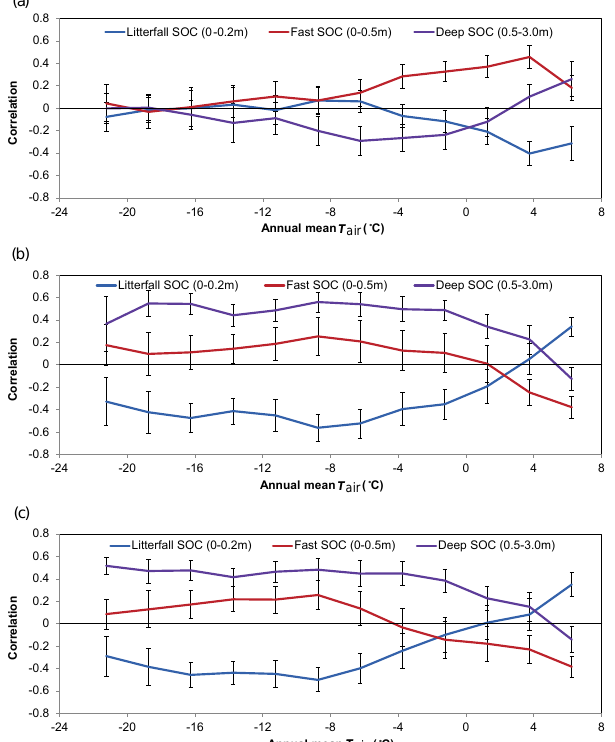
Figure 6. Correlations between annual carbon fluxes and climate variables including (a) annual mean air temperature, (b) annual mean snow water equivalent (SWE), and (c) annual mean snow cover extent (SCE). The annual carbon fluxes include NEE and its two component fluxes (i.e., NPP and soil heterotrophic respiration R h ). The correlations were binned into 2.5 ◦ C intervals. The stan- dard deviation of correlations across each climate zone is shown by the error bars.